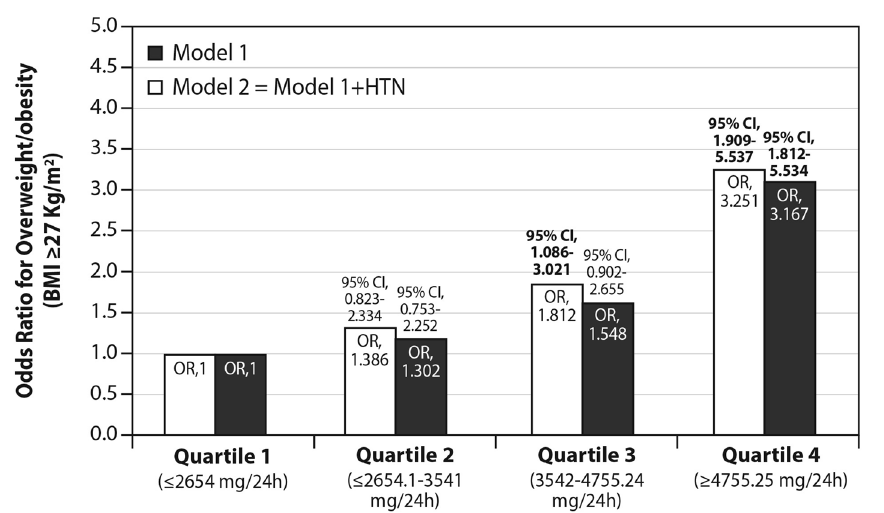
Figure 5. The independent association between sodium excretion and odds for overweight/obesity. Results from a multivariate logistic regression: Model 1 (solid bars)—represents adjustment to other explanatory variables. Model 2 (open bars) represents model 1 + adjustment to measured hypertension (≥ 140 and/or 90 mm/Hg). As compared to the lowest level (Q1), the highest level of sodium excretion (represented as Q4) was significantly and positively associated with higher odds for overweight/ obesity in both models. Adjustment for: the presence of diabetes (0 = no; 1 = yes), coronary heart disease (0 = no; 1 = yes), age (up to 43.9 = 0; 44–65 = 1), , ideal physical activity (As recommended by the American College of Sports Medicine [ACSM]-150 weekly minutes or more of moderate intensity or 75 weekly minutes of intense physical activity; 0 = no; 1 = yes) and sodium excretion quartiles (first quartile = reference]) and sex (0 = female; 1 = male) + (in model 2 only) measured hypertension (≥ 140 and/or 90